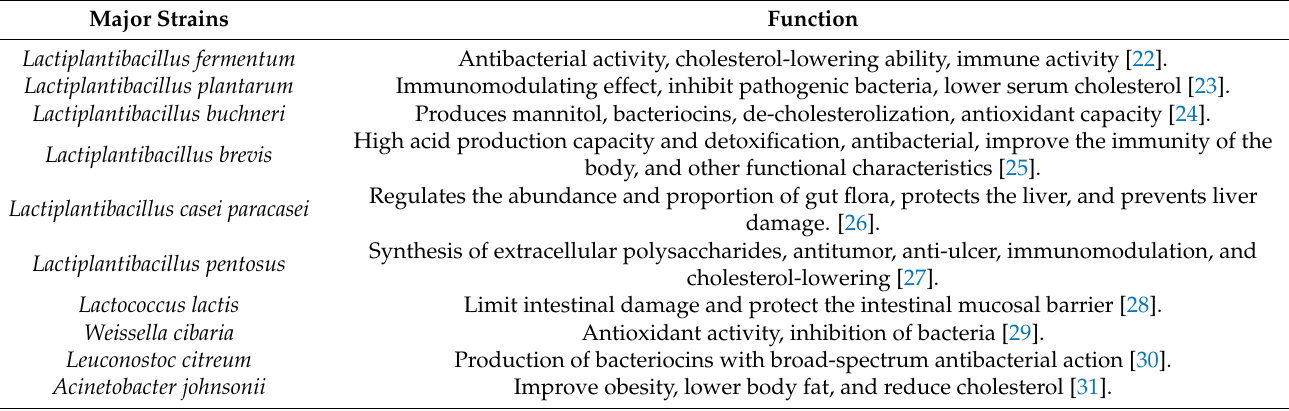
Table 3. Major active microorganisms in